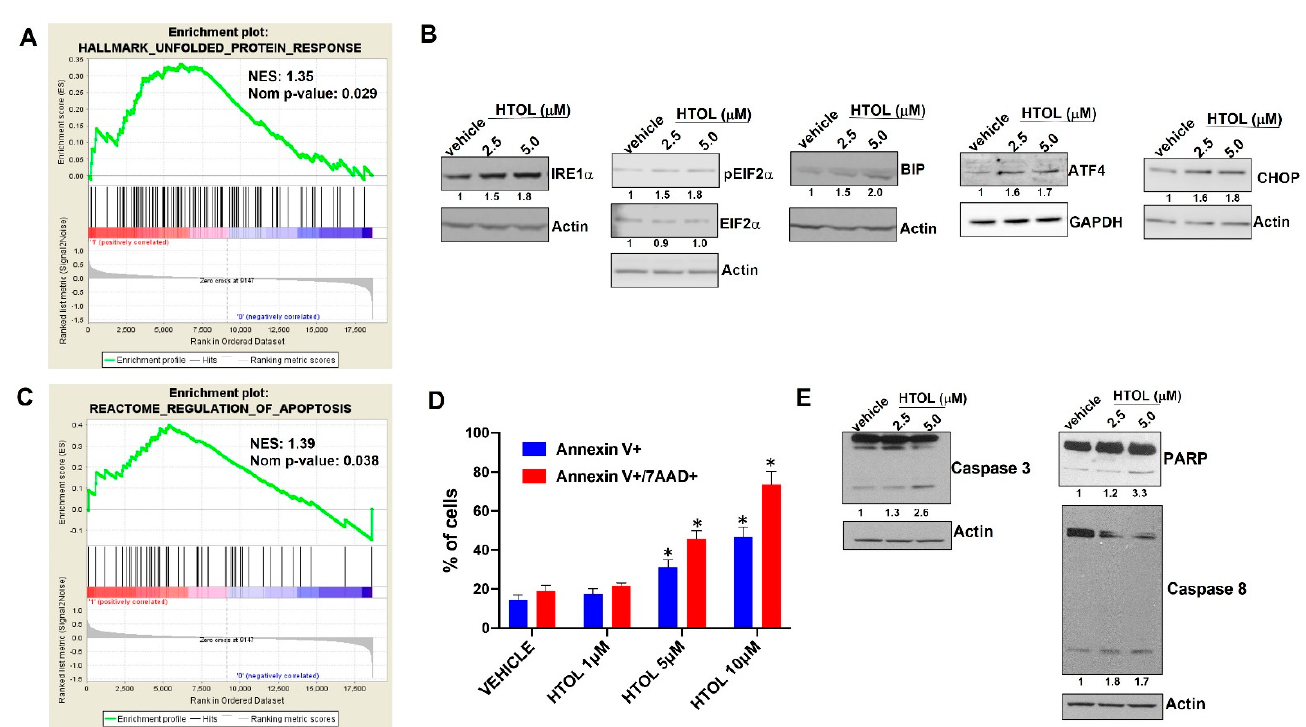
Figure 2. HTOL induces ER stress, UPR and apoptosis of JJN3 cells. ( A ) GSEA performed 24 h after treatment of JJN3 cells with 5.0 μ M HTOL shows enrichment of UPR genes; normalized enrichment score (NES) and nominal p -value parameters are reported. ( B ) Western blot (WB) analysis of IRE1 α , phospho-EIF2 α , EIF2 α , BIP, ATF4 and CHOP in JJN3 whole cell lysates after HTOL treatment for 24 h; actin or GAPDH were used as loading control. ( C ) GSEA performed 24 h after treatment of JJN3 cells with 5.0 μ M HTOL shows enrichment of apoptotic genes; normalized enrichment score (NES) and nominal p -value parameters are reported. ( D ) Annexin V/7-AAD staining of JJN3 cells after treatment with HTOL for 24 h. ( E ) WB of caspase-3, caspase-8 and PARP1 in JJN3 cells after 24 h of HTOL treatment; actin was used as loading control. * p < 0.05 as compared to vehicle-treated cells.